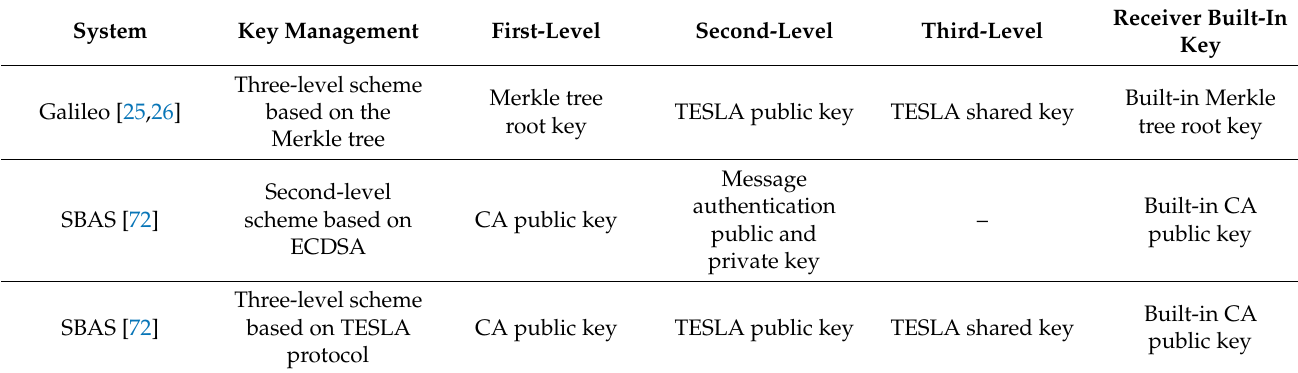
Table 8. Key management scheme.